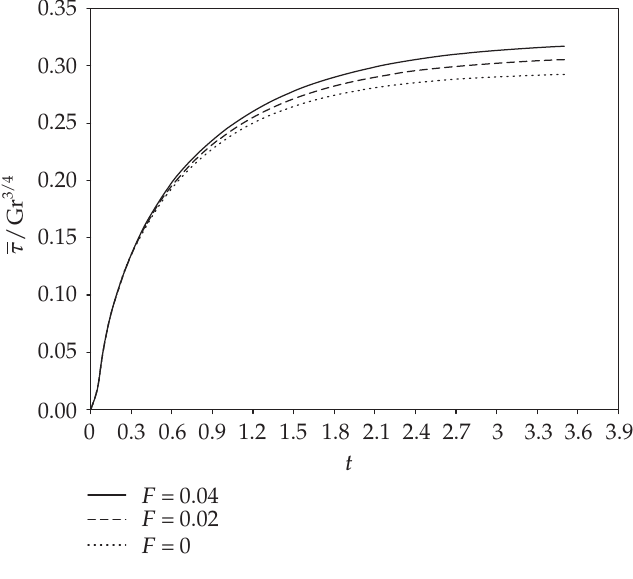
Figure 5.12 . The e ff ect of radiation parameter on average skin fric- tion at M = 1, m = 1, and Pr = 0 . 7.